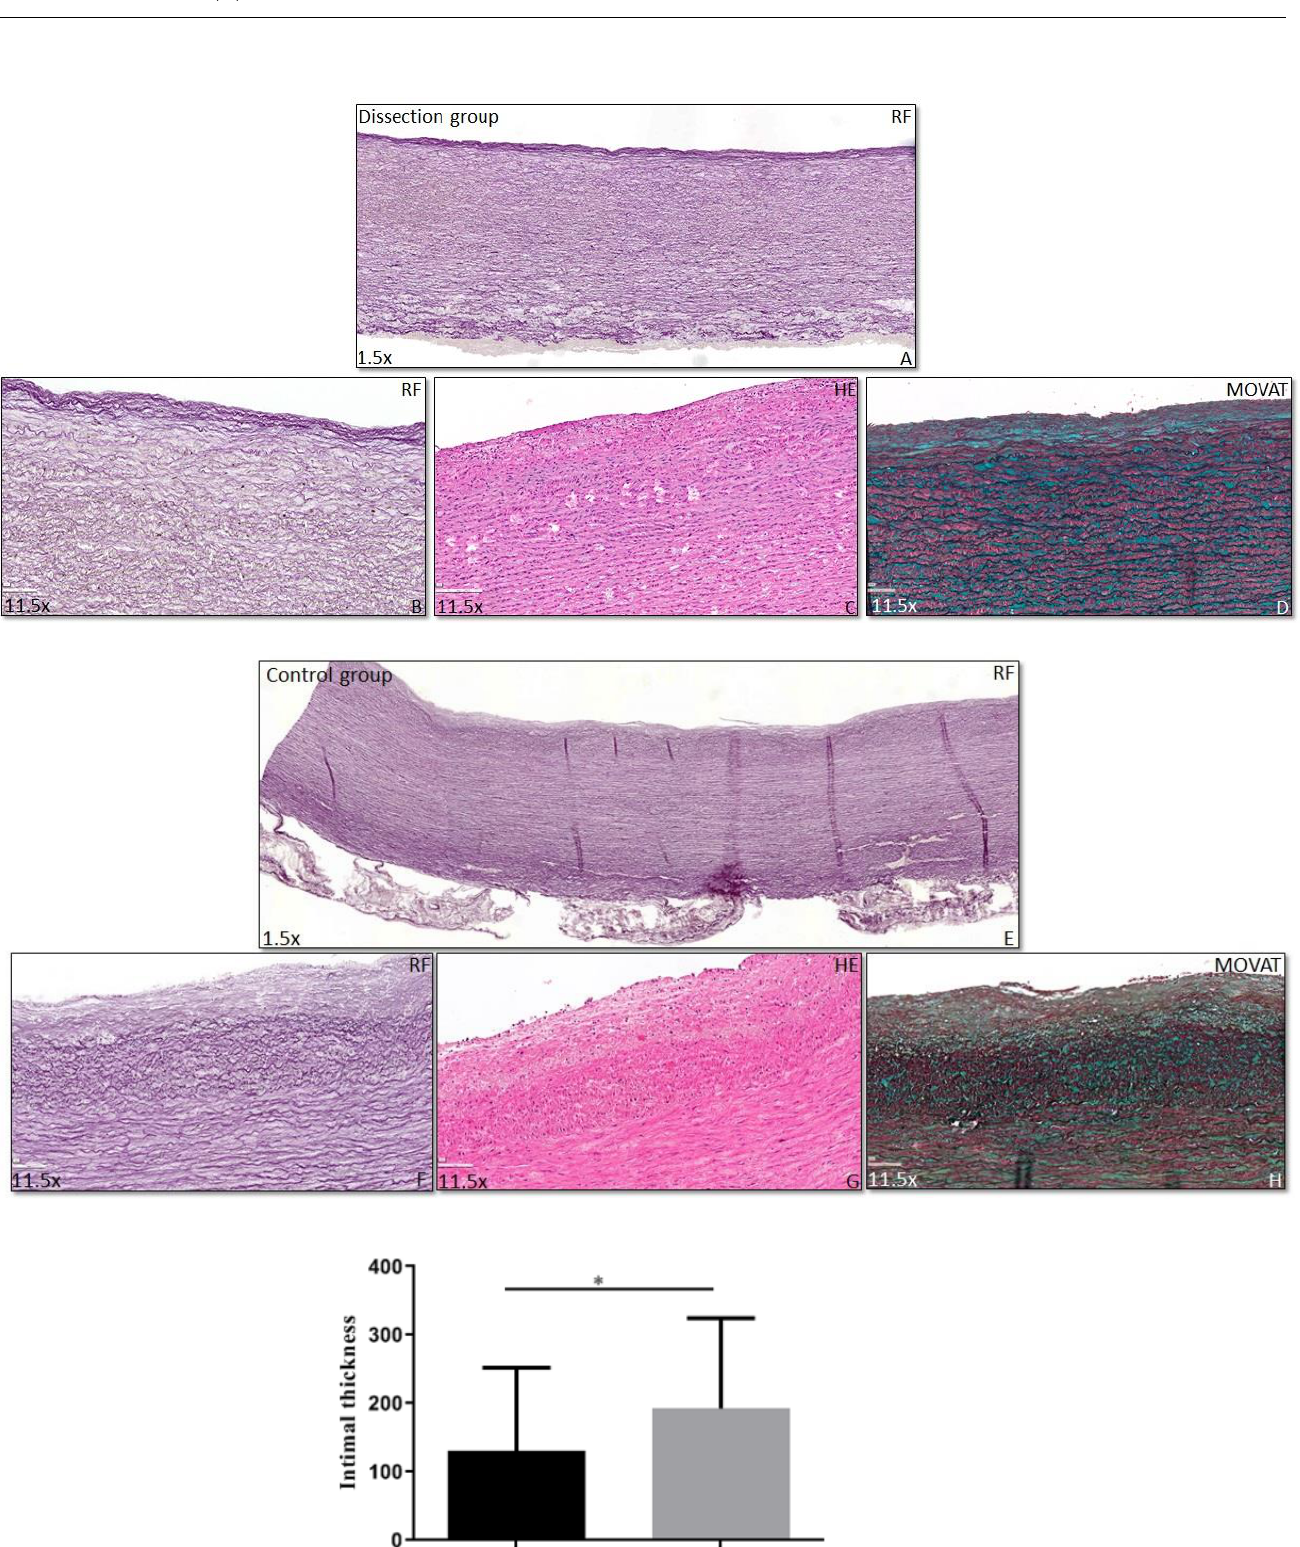
Figure 4. Intimal thickness. Transverse histologic sections (4 μm) stained for Resorcin Fuchsin (RF), Haematoxylin Eosin (HE), and MOVAT. The intimal layer, indicated with the dashed line, is significantly thinner in the dissection group (a patient without Marfan or a bicuspid aortic valve) ( A – D ) than in the control group ( E – H ) (Graph I ). Magnification ( A , E ) 1.5 × , ( B – D , F – H ) 11.5 × , *: p < 0.05 .